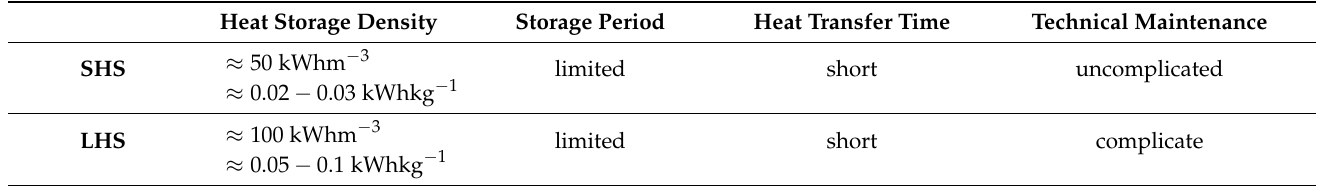
Table 7. Technical parameters of SHS and LHS, reprinted/adapted with permission from Ref. [27], 2022, Elsevier.